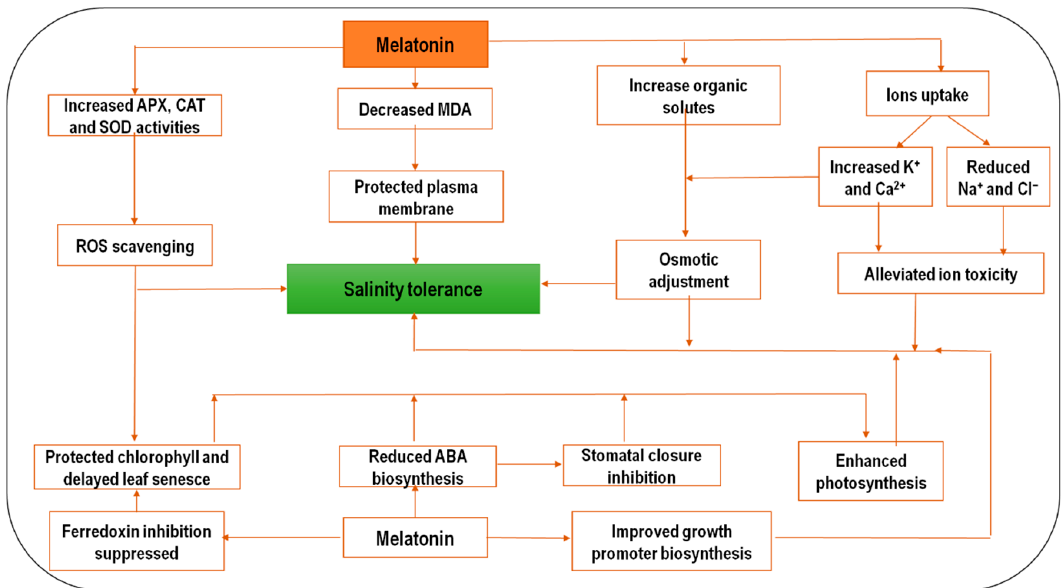
Figure 1. A schematic summary of the physiological responses of melatonin employed in salinity stress tolerance (based on available research findings). The impact of salinity in several physiological reactions such as reactive oxygen species (ROS), abscisic acid (ABA), sodium and chloride ions, and stomatal closure. Additionally, melatonin promotes plant tolerance to salinity stress by enhancing several pathways such as membrane integrity, chlorophyll, photosynthesis, plant growth, and potassium and calcium ions.